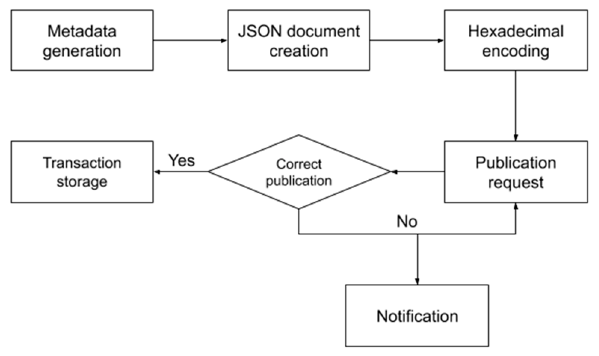
Figure 2. AUDABLOK’s workflow for management of user-generated contributions.